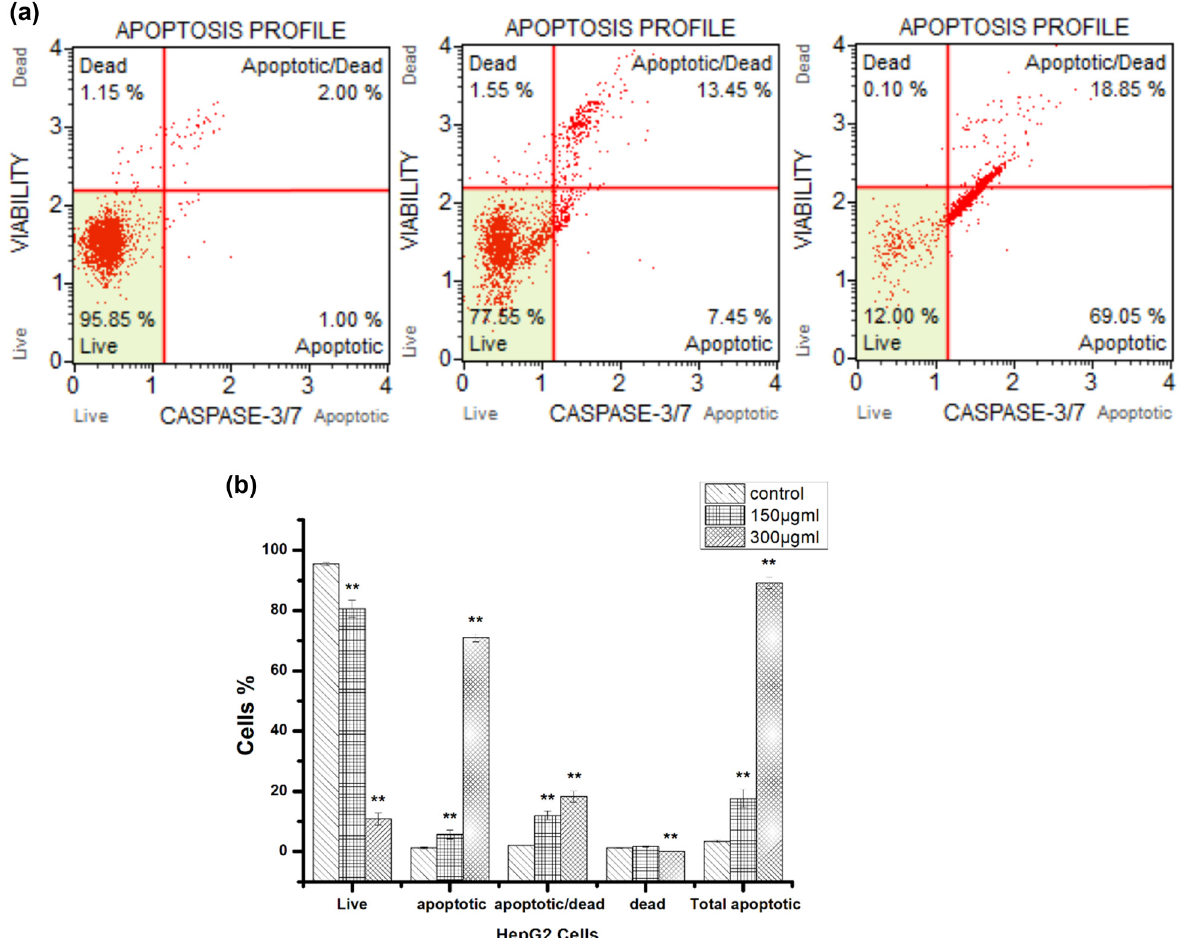
Figure 4: Hexane extract induced caspase activation in HepG2 cells as revealed by Muse ® Caspase 3/7 Kit staining. ( a ) In each panel, the lower left quadrant designates cells negative for dead cell marker and caspase 3/7, lower - right quadrant cells negative for dead cell marker and positive for caspase 3/7, upper right quadrant cells positive for dead cell marker and caspase 3/7, and upper left quadrant cells positive for dead cell marker and negative for caspase 3/7. ( b ) Proportions of live, apoptotic, apoptotic/dead, and total apoptotic cells. ** p <